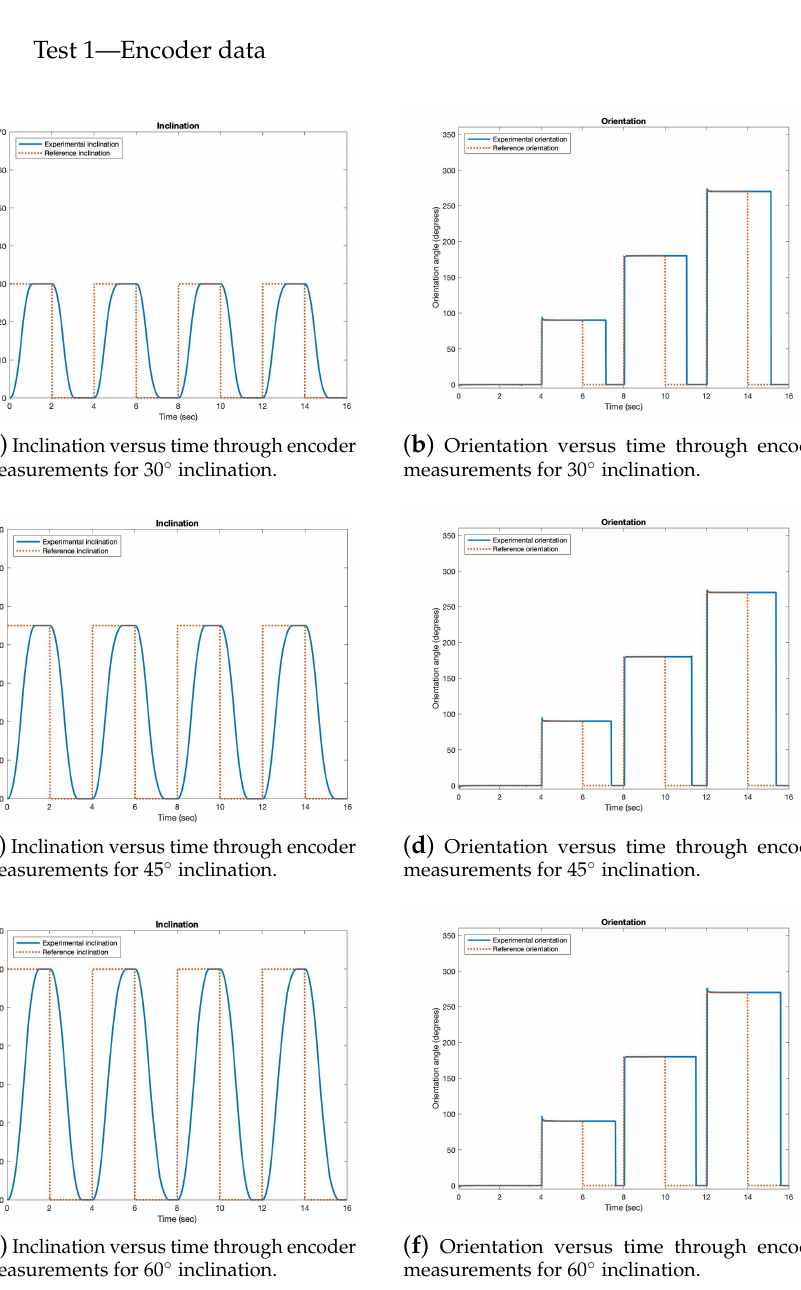
Figure 18. Test 1—Encoder data. Fixed 30 ◦ , 45 ◦ and 60 ◦ inclination for four orientations: 0 ◦ , 90 ◦ , 180 ◦ and 270 ◦ . The blue line is the experimental data obtained from the encoder and the orange dotted line is the